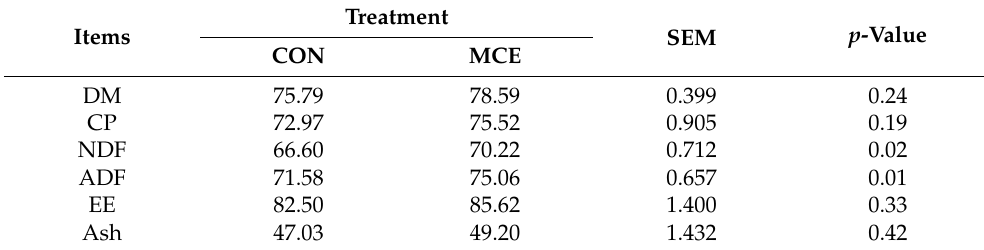
Table 3. Effects of MCE on apparent digestibility of nutrients (%).